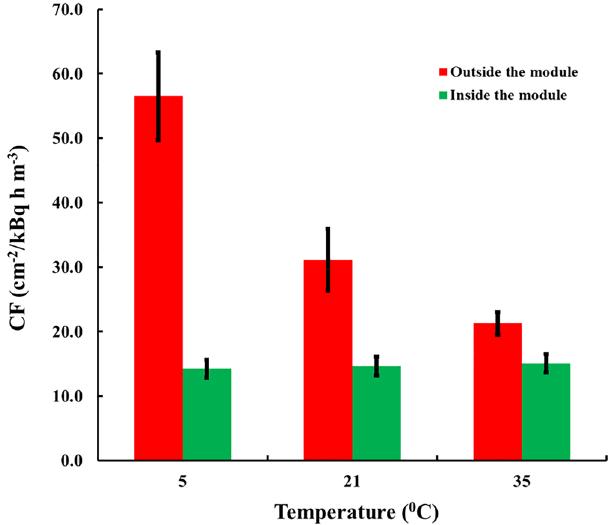
Figure 5. Experimental results with adsorbers of ACC-10 fabric of sensors exposed outside ( CF 0 ) and inside ( CF ) modules of 20 µm LDPE foil.